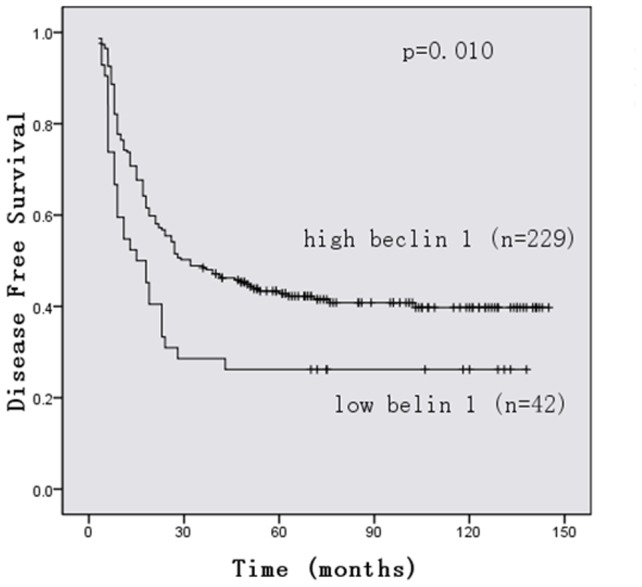
Kaplan-Meier estimates of the probability of disease free survival (DFS).Patients with high expression Beclin 1 showed significantly longer DFS than those with Beclin 1 low expression. (p = .010).